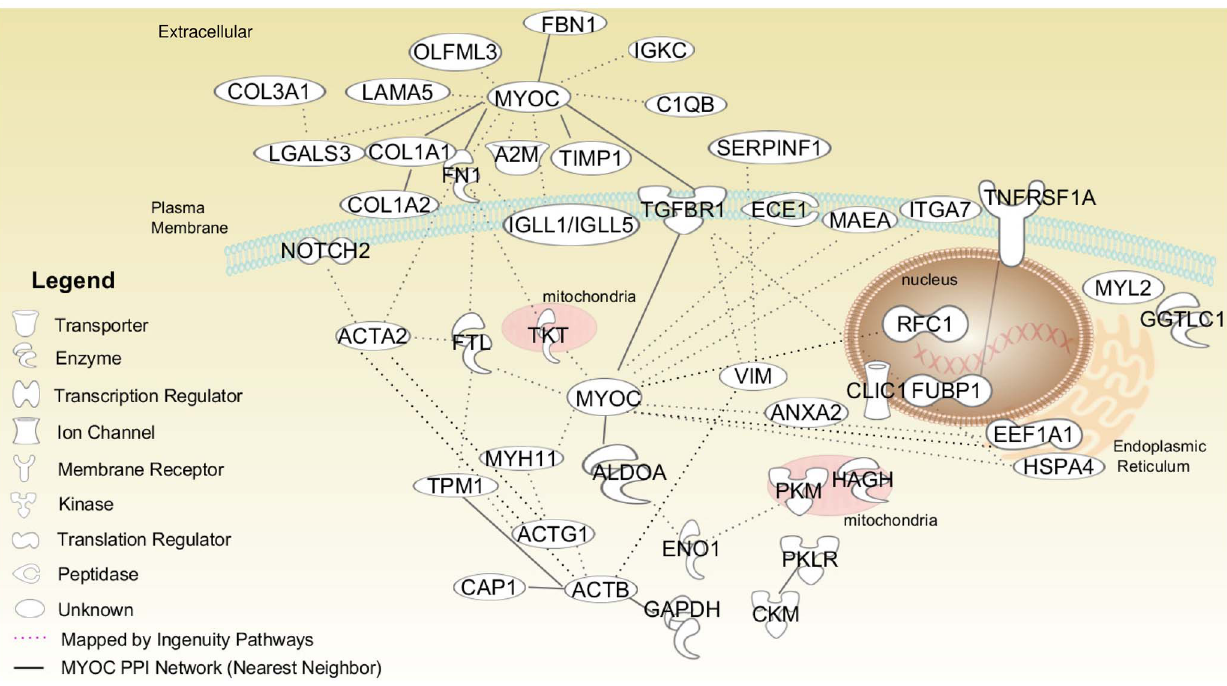
Figure 6. Myocilin interaction network. First neighbors of myocilin (MYOC) in the entire high-confidence human protein-protein interaction (PPI) network.